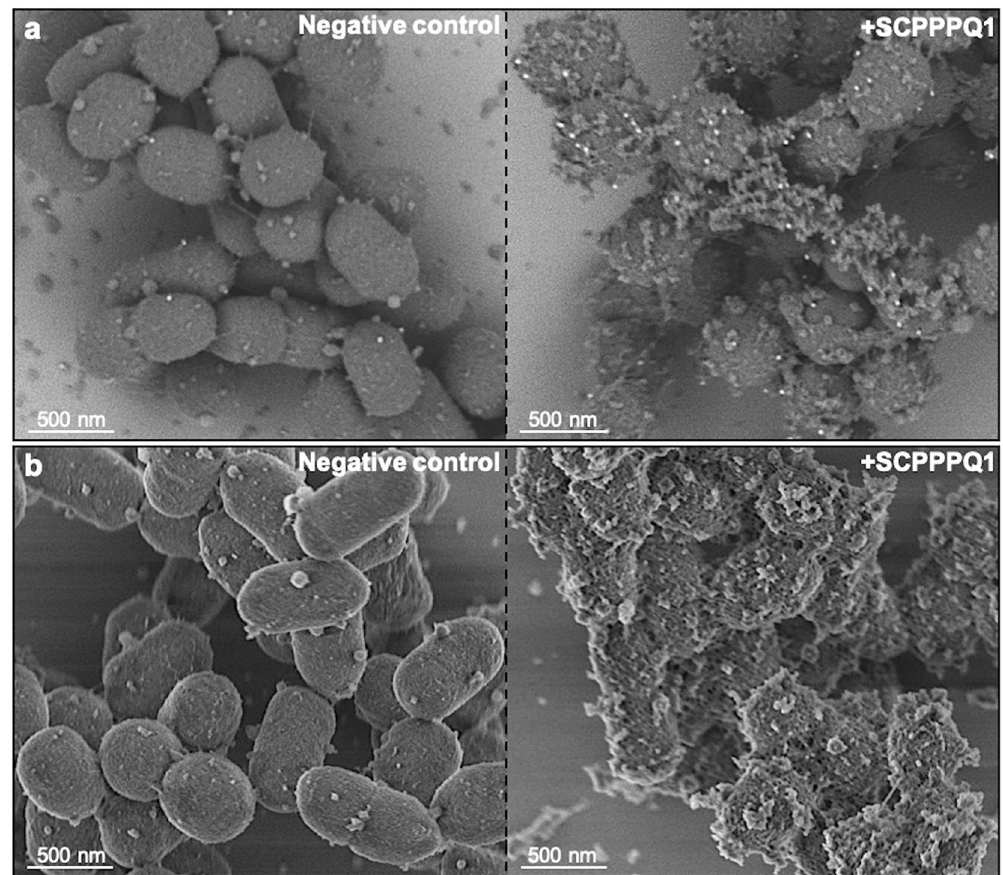
Figure 6. Localisation and effect of SCPPPQ1 on the surface of P. gingivalis using SEM. ( a ) SEM micrographs of colloidal gold immunolabeled preparation showing the presence of gold particles (white dot) on bacteria from samples treated with + SCPPPQ1 (right) and their paucity in the negative control (left) at 20 min. ( b ) SEM micrographs showing the normal appearance of the bacterial surface in the negative control (left) and its disruption of the bacterial surface in samples treated with + SCPPPQ1 (right) at 20 min. Micrographs are representative from four different